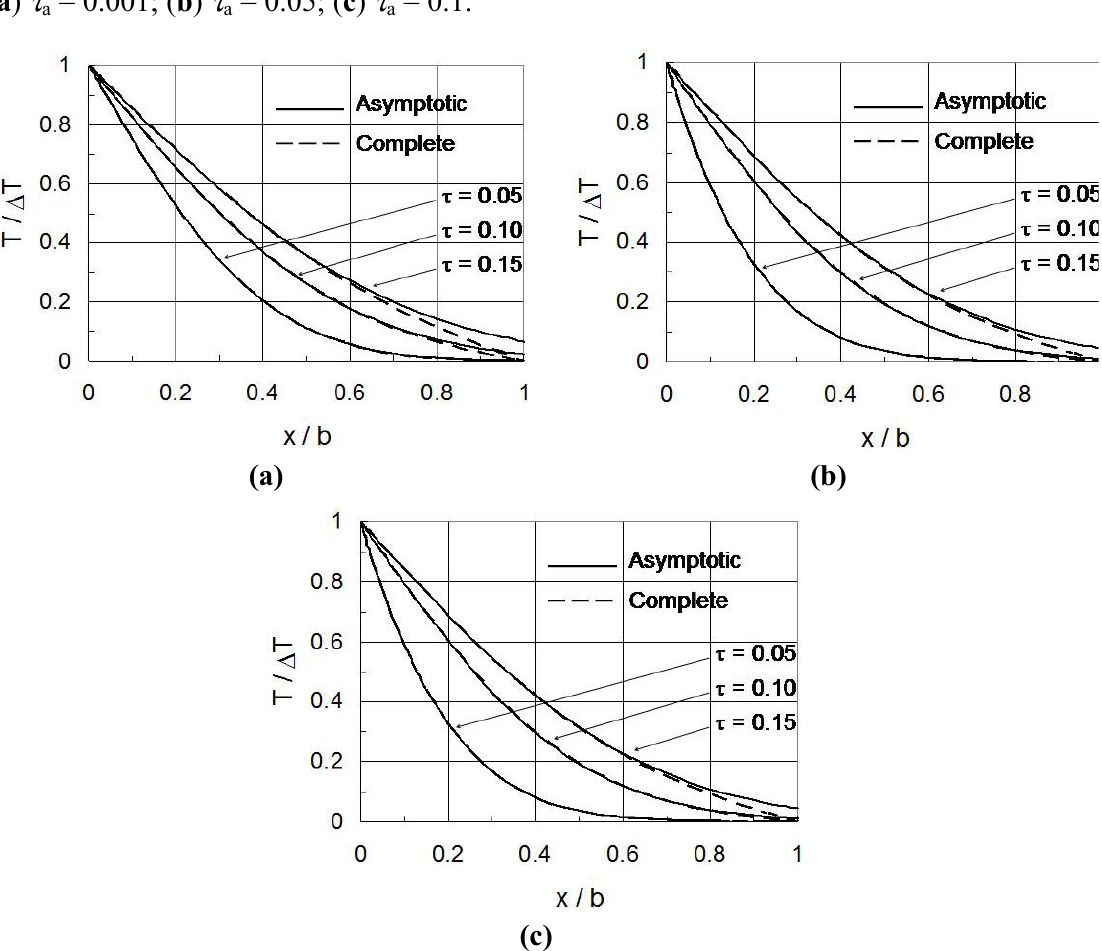
Figure 2. Temperature field: asymptotic and complete solutions for a homogeneous